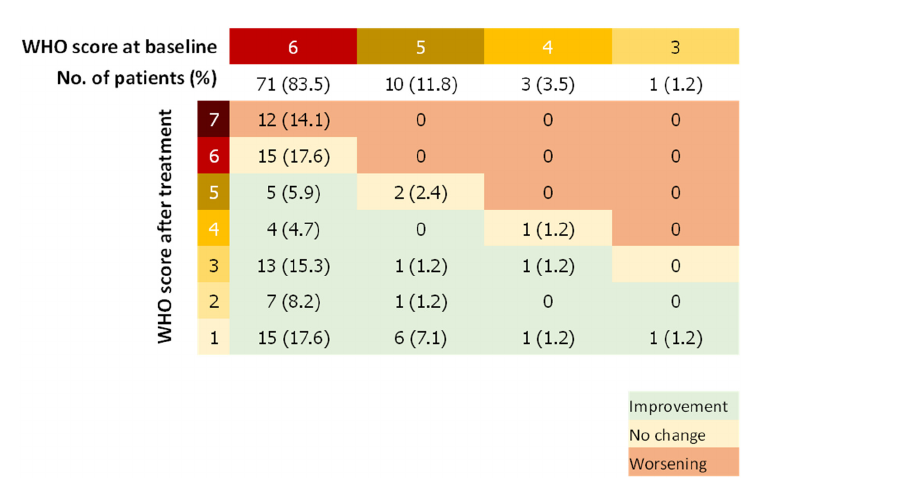
Figure 2. Oxygen Support Flow Chart.